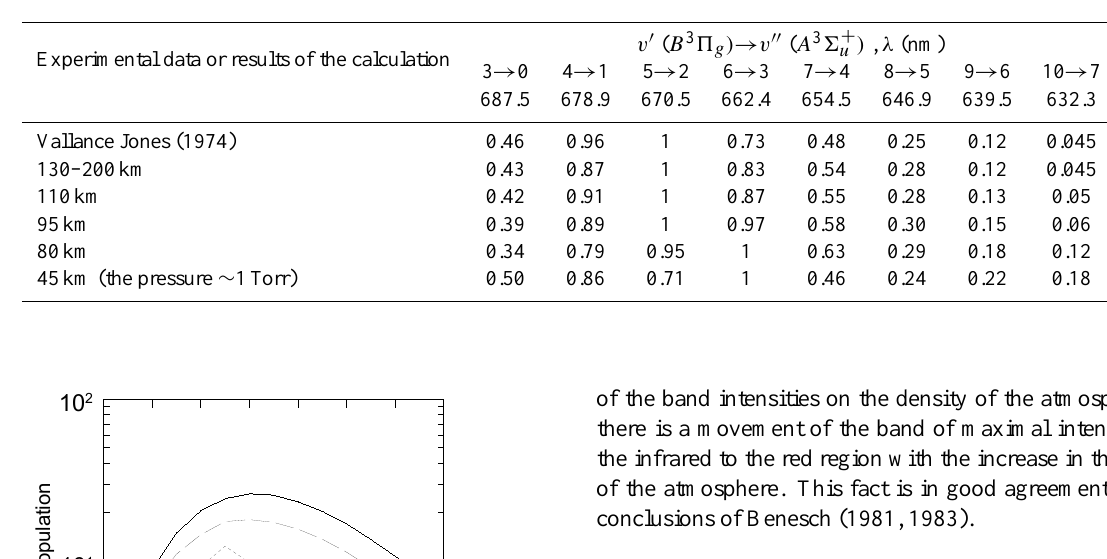
Table 5. Relative intensities of bands for 1PG 1v =3 sequence.